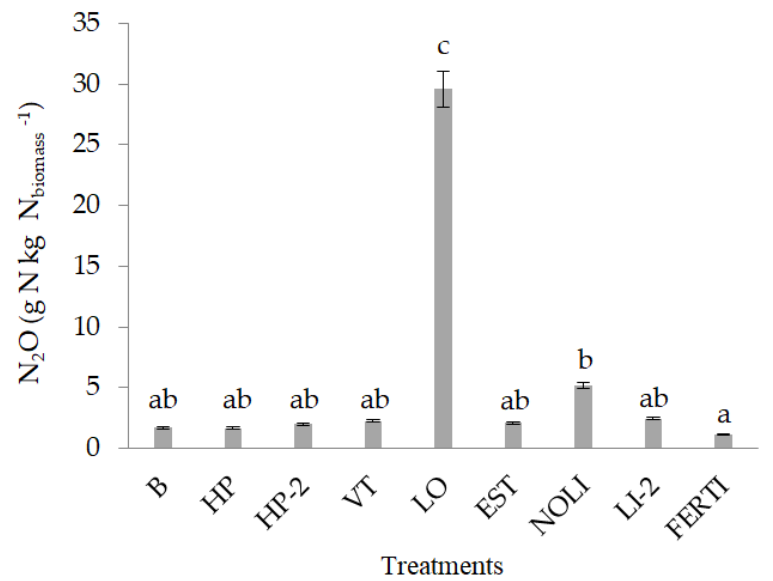
Figure 4. Yield-scaled N 2 O according to treatment. Different letters indicate significant differences between treatments ( p < 0.05). Bars represent standard errors. HP: wastewater treatment biosolid + Phoenix dactilifera leaf prunings; HP-2: agrifood sludge from pear processing wastewater + Phoenix dactilifera leaf prunings; VT: vermicompost cow manure; LO: biosolid; EST: cow manure; NOLI: NPK inorganic fertilizer; LI-2: NPK + DMPP inorganic fertilizer; FERTI: fertigation.